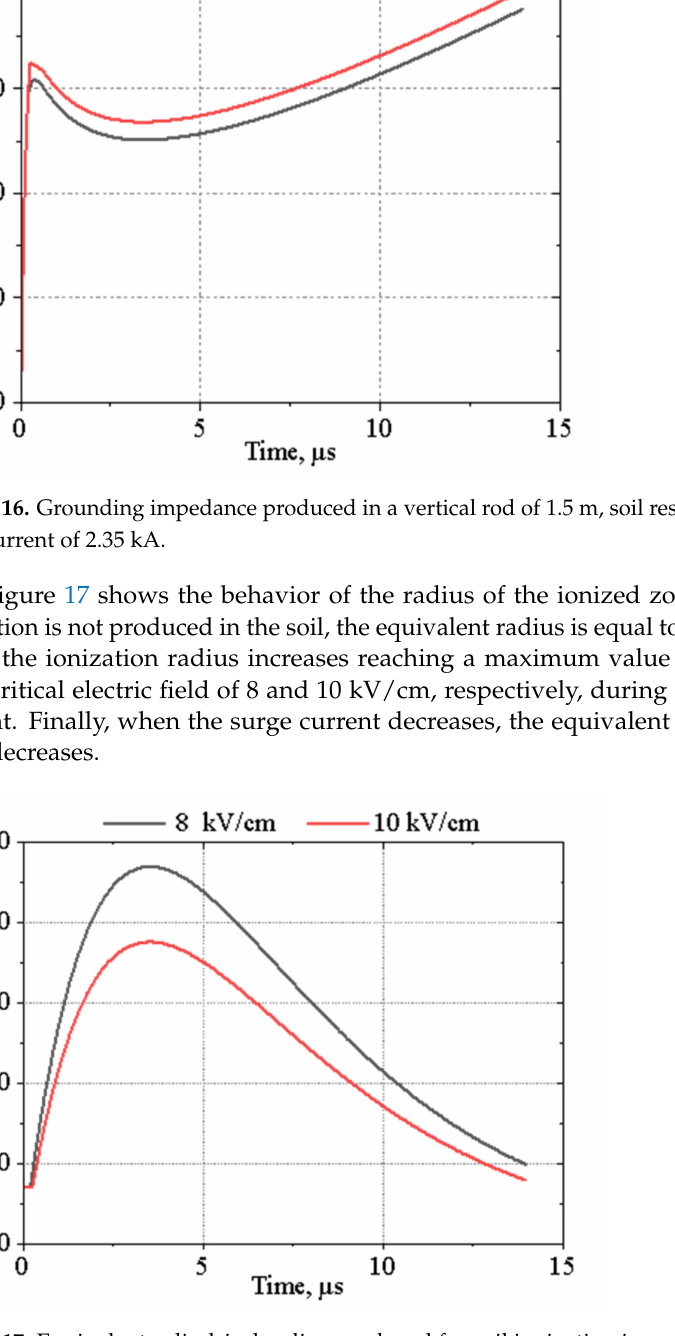
Figure 17. Equivalent cylindrical radius produced for soil ionization in a vertical rod of 1.5 m, soil resistivity of 160 Ω m and peak current of 2.35